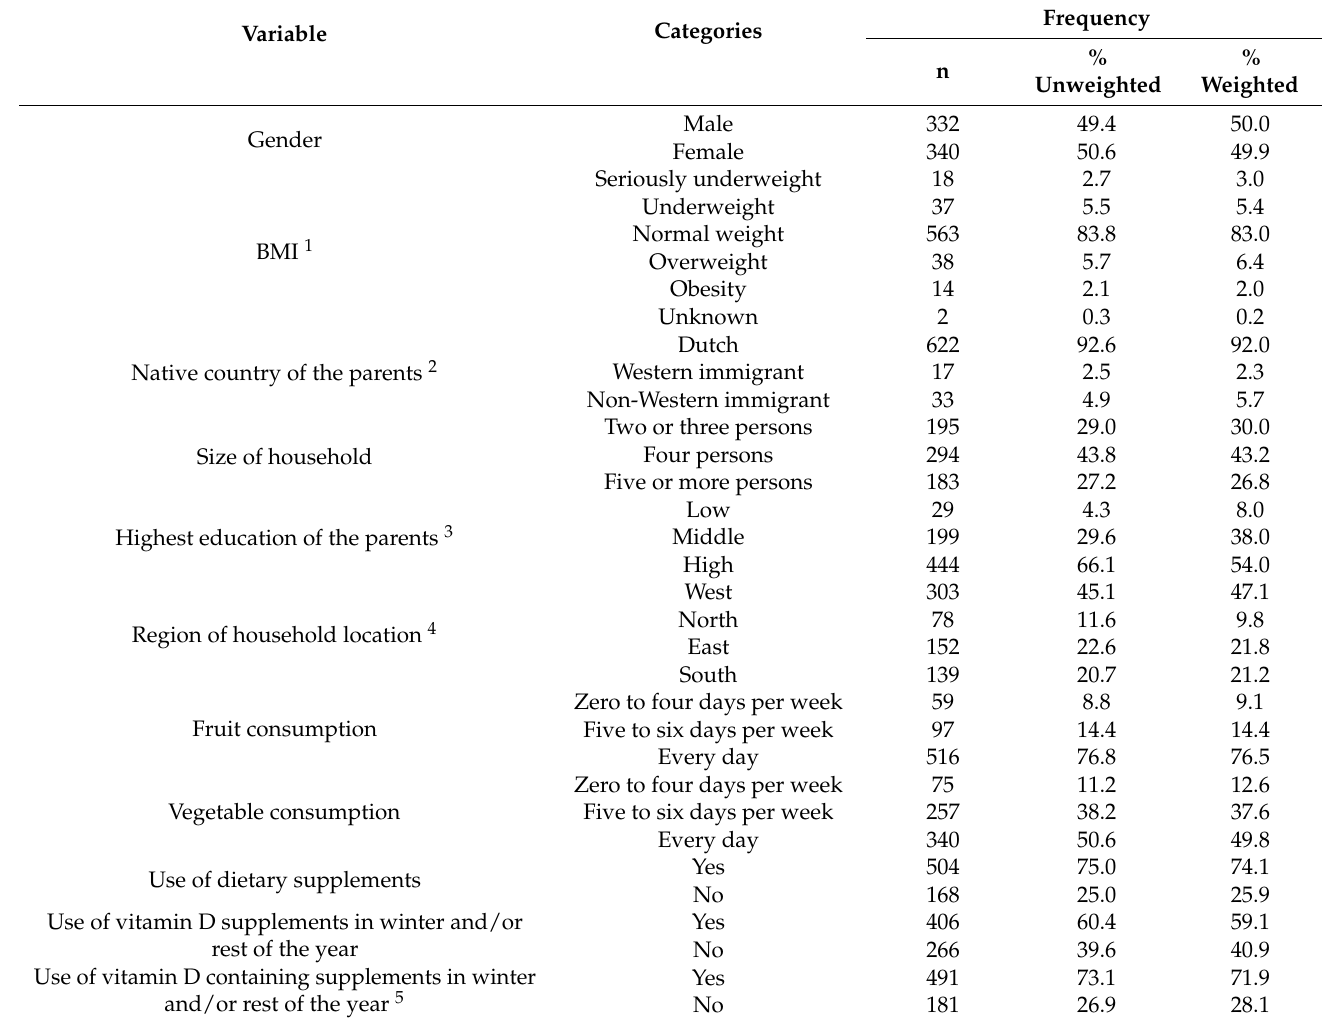
Table 1. Population characteristics of children aged one to three years in the Netherlands unweighted and weighted for demographic properties (DNFCS 2012–2016; n =